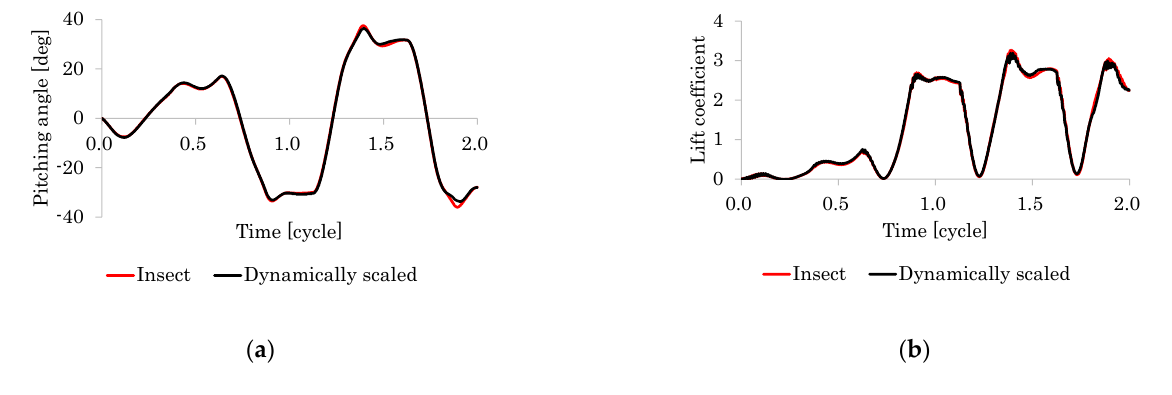
Figure 8. Time histories of ( a ) the pitching angular displacement and ( b ) the nondimensional lift.